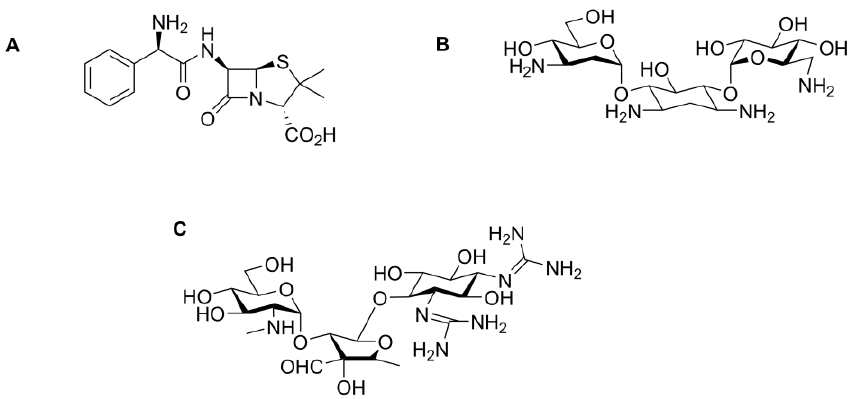
Figure 6. Chemical structures of ( A ) ampicillin ； ( B ) kanamycin and ( C ) streptomycin.